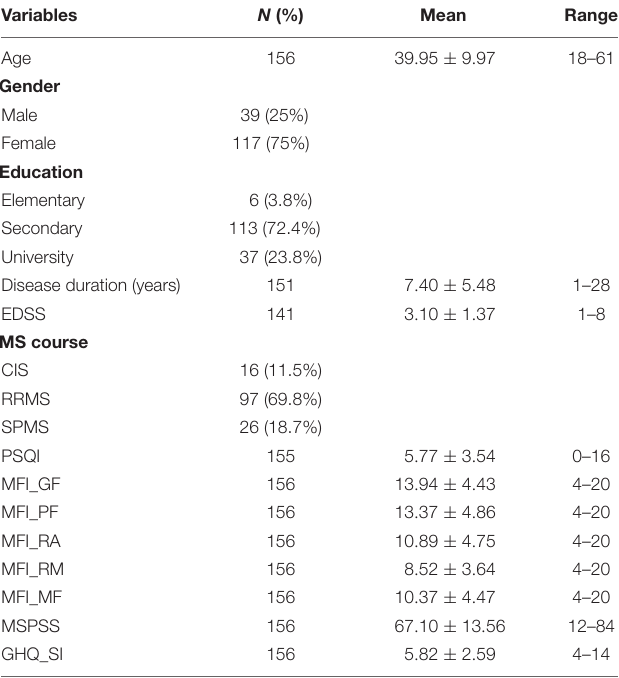
TABLE 1 | Description of the study population.